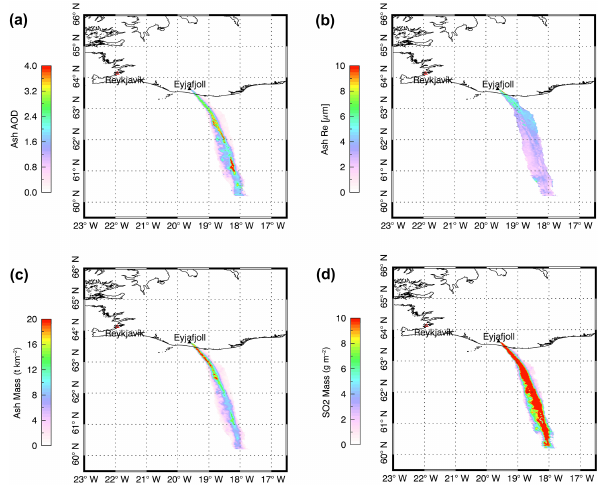
Figure 6. Maps of ash aerosol optical depth at 550nm (a) , effective radius (b) , mass (c) , and sulfur dioxide mass (d) calculated with the VPR procedure. From Aqua MODIS over Eyjafjallajökull on 11 May 2010 at 14:05GMT.